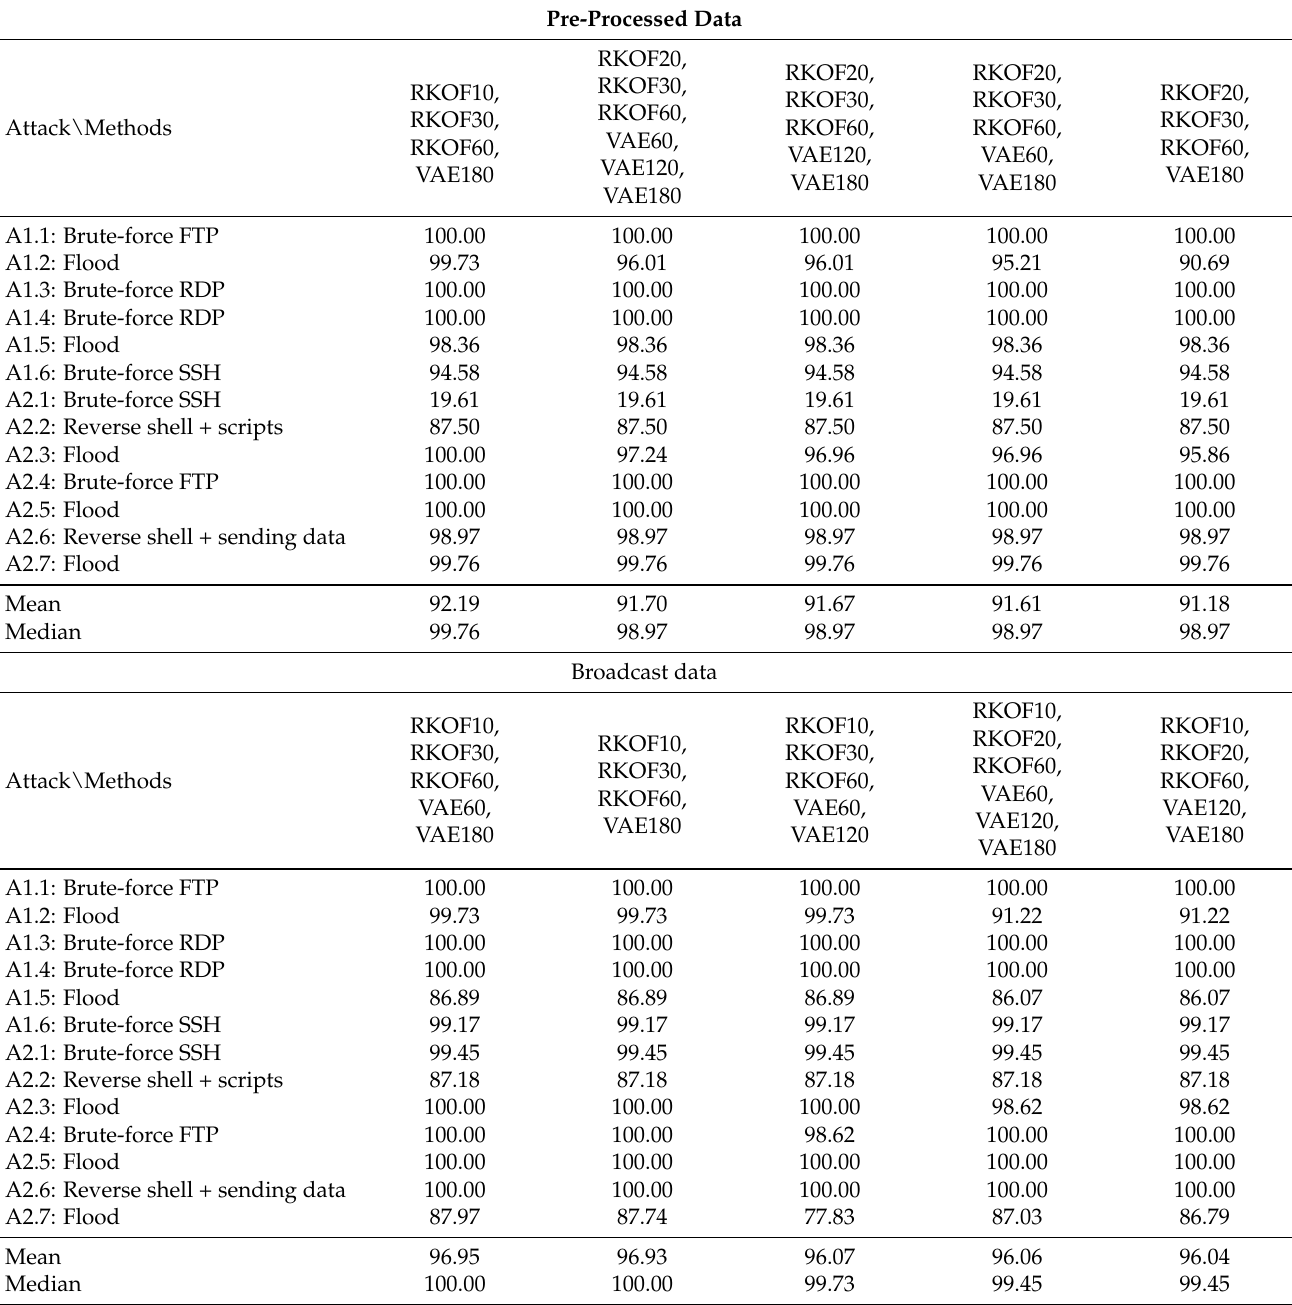
Table 5. Percentage of flows within attacks labelled as an anomaly for method